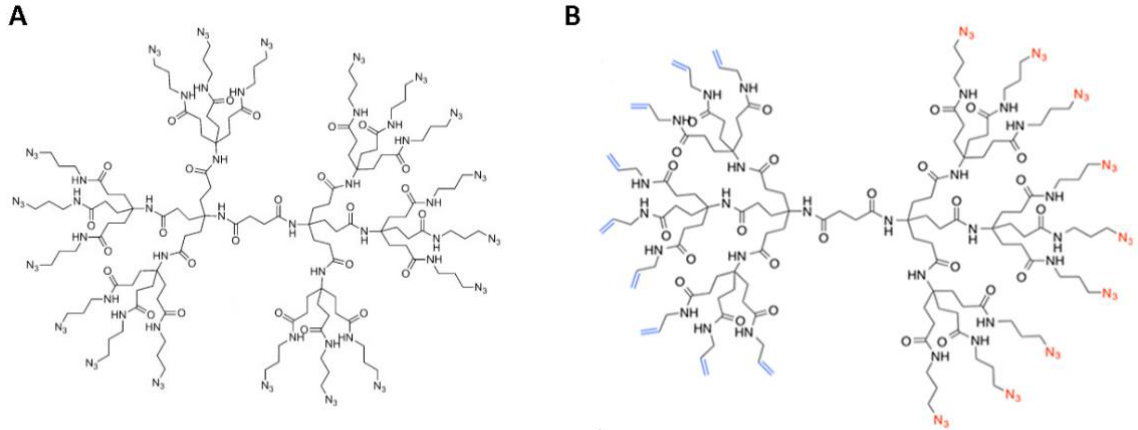
Figure 1. DendrimerA (panel A ) and Janus-type DendrimerB (panel B ) used in the study.